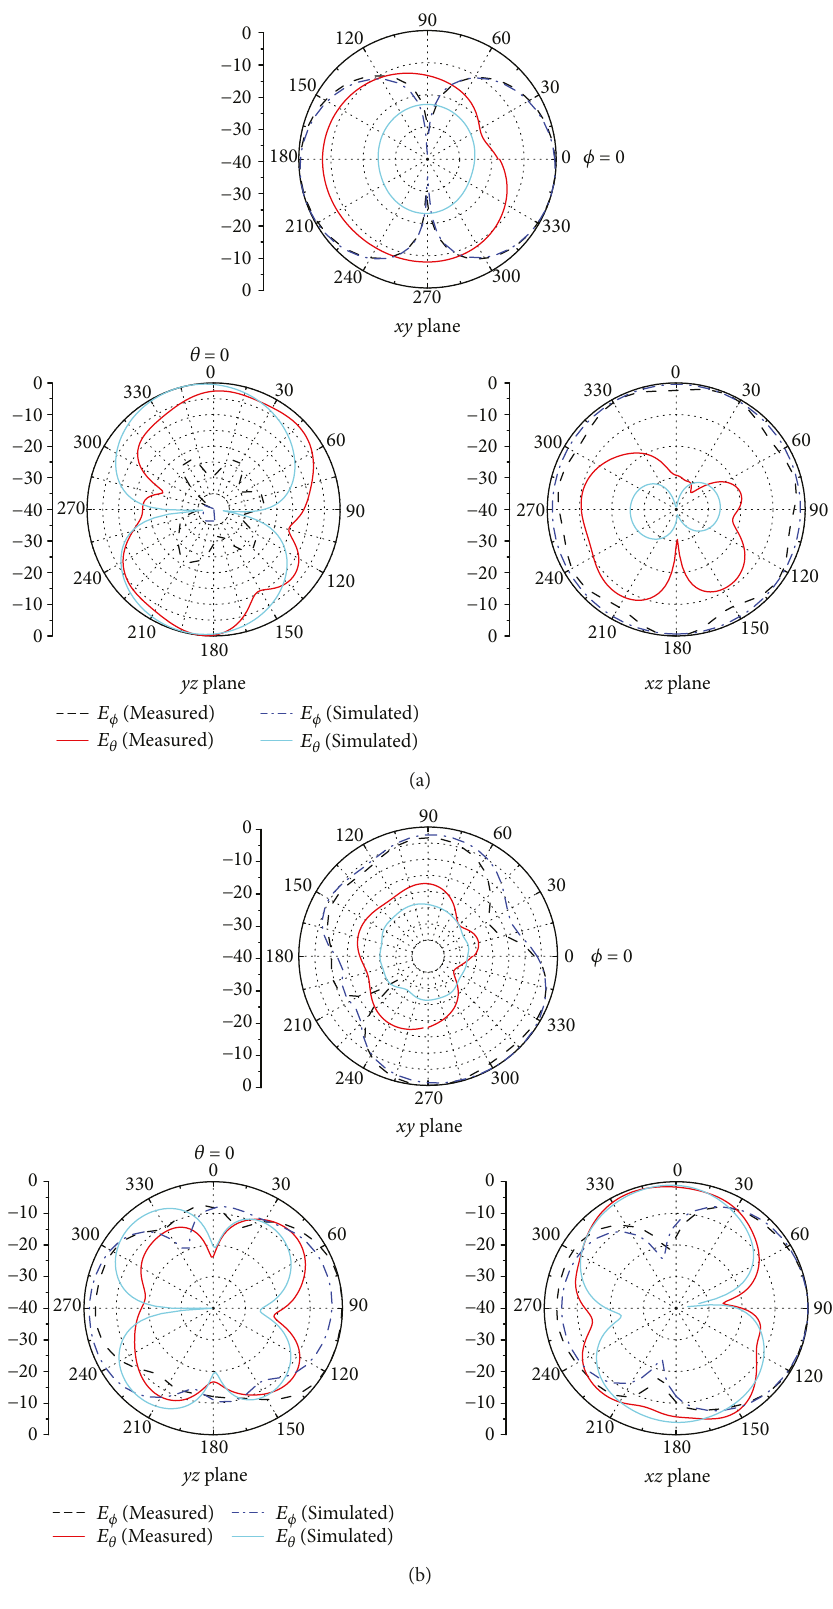
Figure 9: Normalized radiation patterns at two resonant frequencies: (a) 0.9GHz and (b)